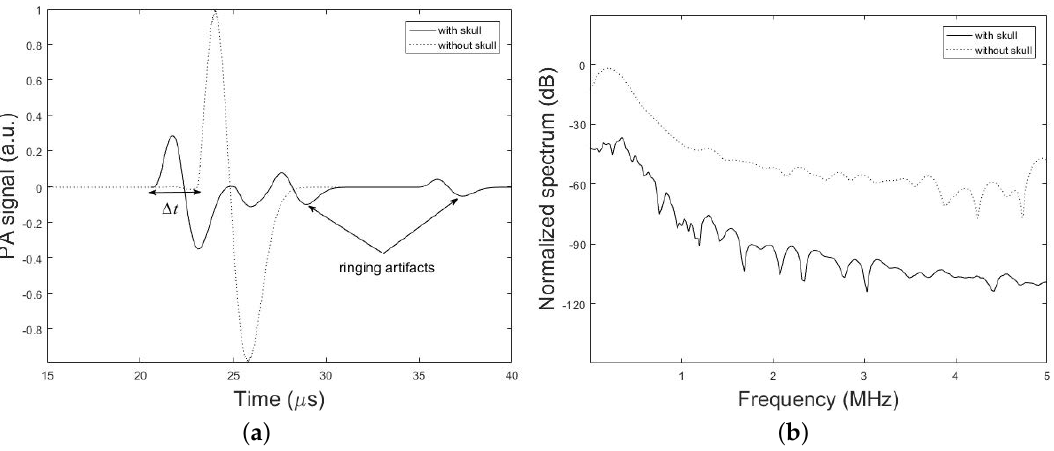
Figure 6. Simulation results. ( a ) PA signals simulated by our simulation method in the presence and absence of a skull tissue. The setup in Figure 2 with the parameters, h = 7 mm, d = 2.7 cm, k = 10 mm, r 0 = 1 mm, r d = 0.25 inch, and T = 5 cm is used. ( b ) Corresponding frequency spectrum of the simulated PA